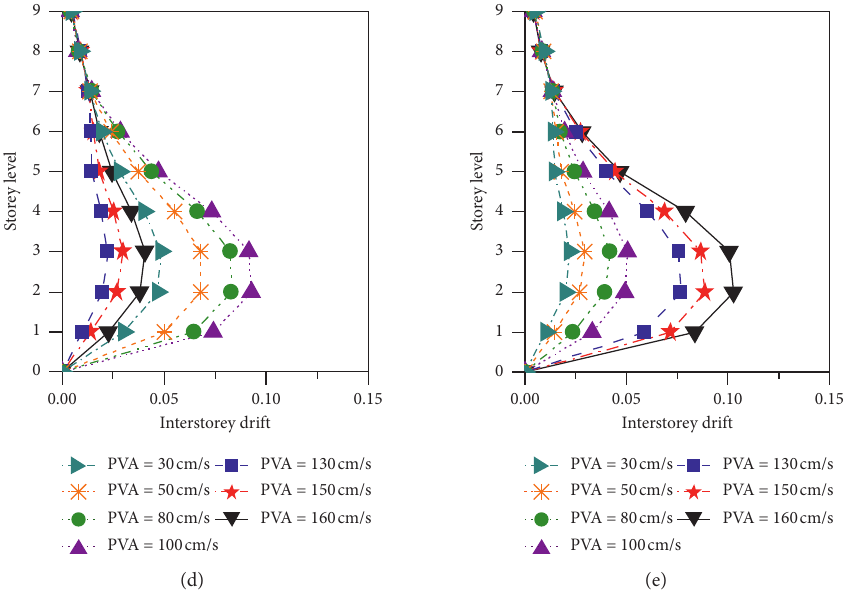
Figure 16: Interstorey drift of building-damper systems subjected to ANEs with different PVAs. (a) BRB. (b) FD. (c) SCD. (d) VD. (e) VED.